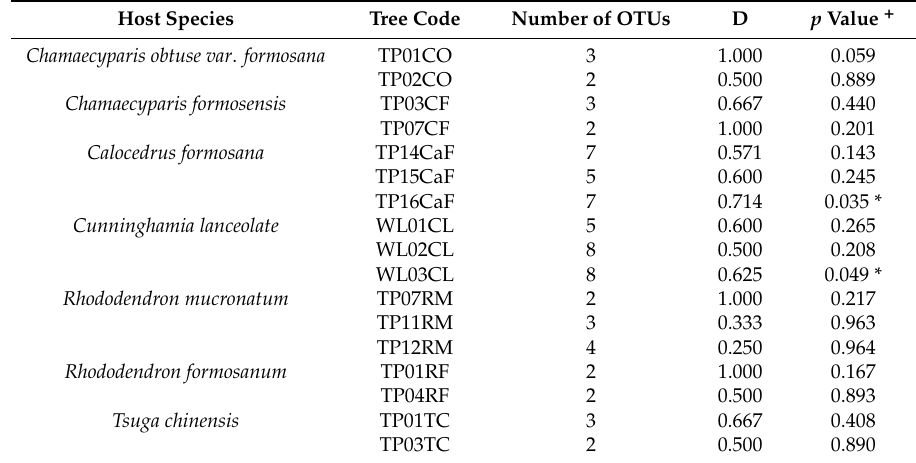
Table 3. Bootstrap K-S test compared the distributions of fungal growth and OTU abundance in the investigated sample trees.